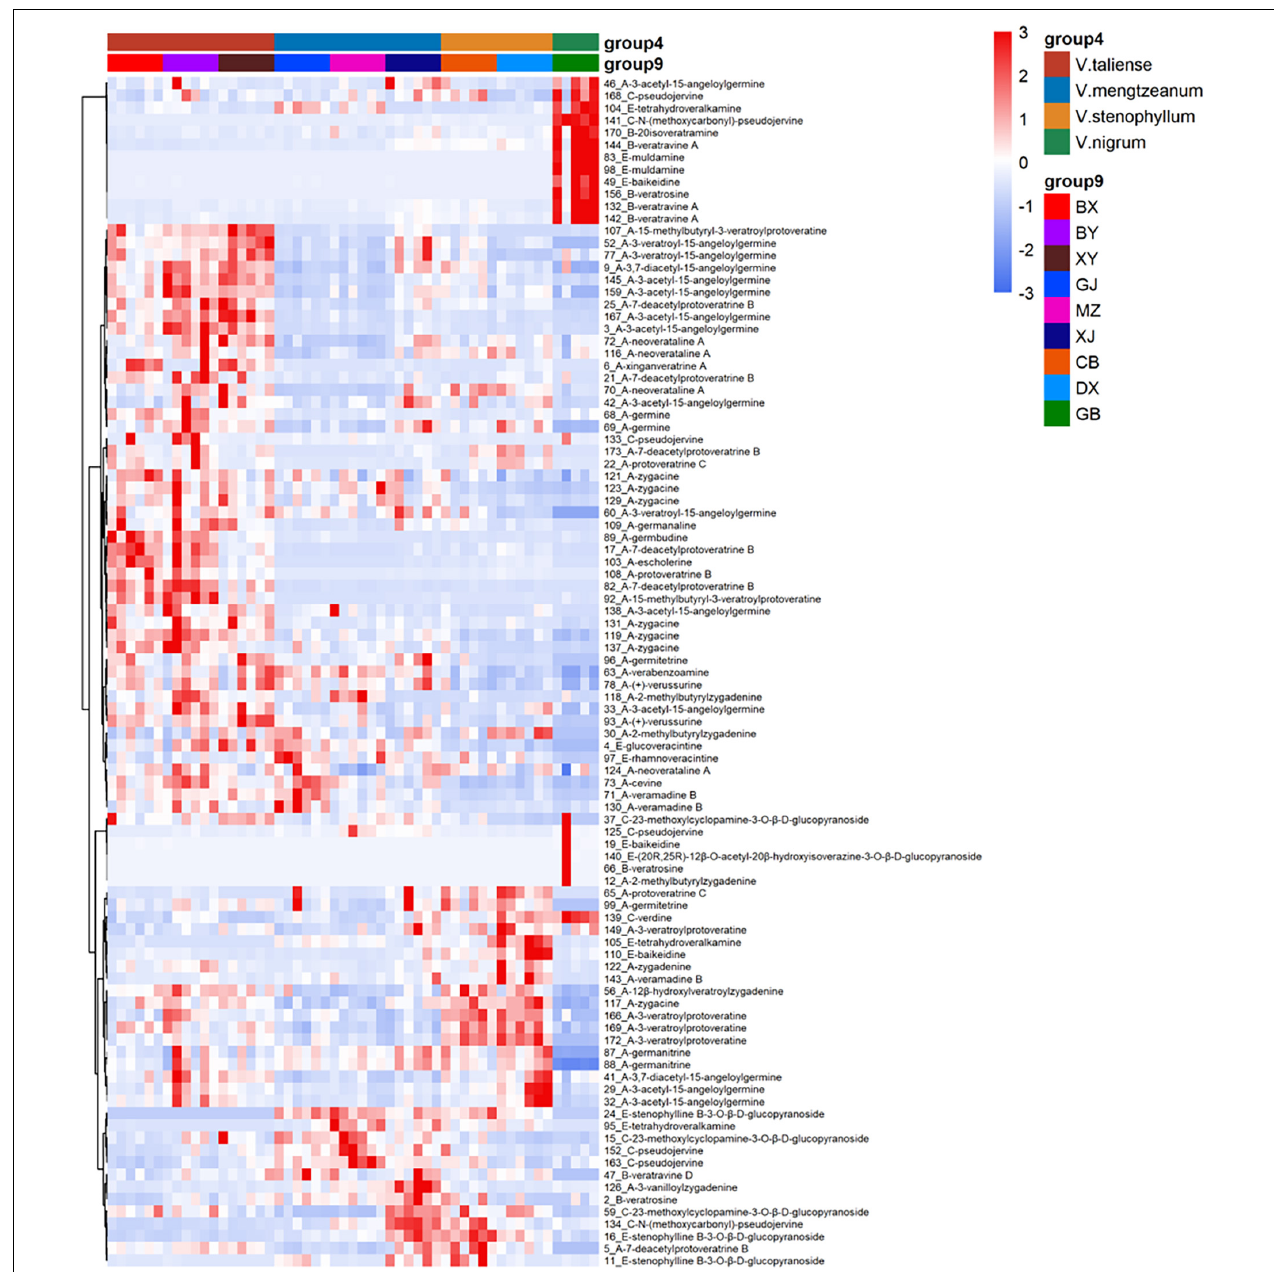
FIGURE 4 | The hierarchical cluster analysis (HCA) of populations.